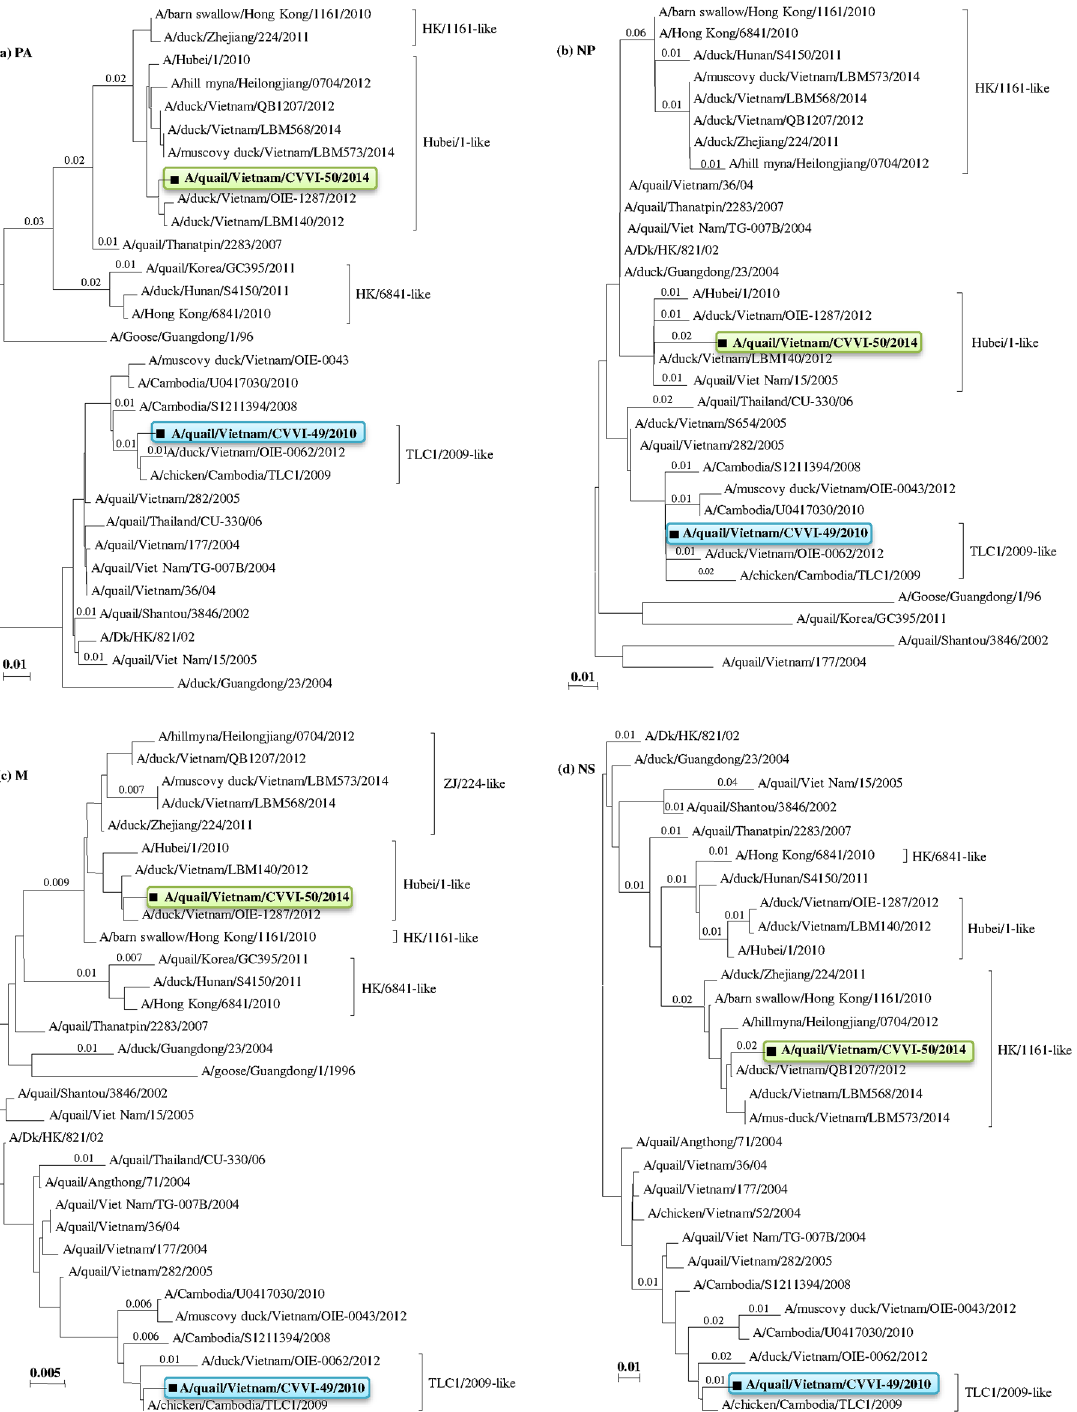
Fig 3. Phylogenetic trees from neighbor-joining analyses of the (a) PA genes, (b) NP genes, (c) M genes, and (d) NS genes of the HPAI H5N1 study strains and reference strains available in the GenBank database. The tree topology was constructed using the MEGA 6.06 program and bootstrap values were obtained from 1,000 resampled datasets. HPAI H5N1 virus clade names were determined based on specific criteria and reference strains, as described by the World Health Organization, World Organization for Animal Health, and Food and Agricultural Organization. The study strains are marked in bold and black